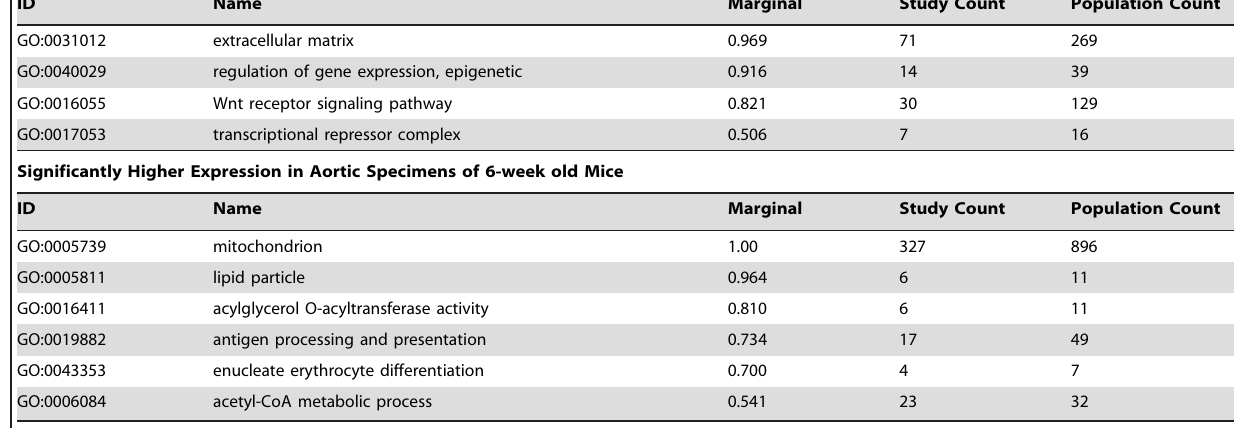
Significantly Higher Expression in Aortic Specimens of Neonatal